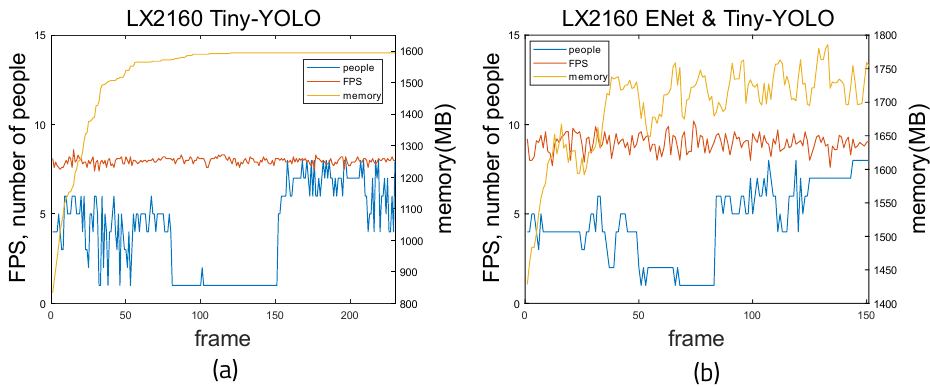
Figure 22. Time measurement result of Tiny-YOLO weight on LX2160 board: ( a ) Tiny-YOLO and ( b ) ENet and